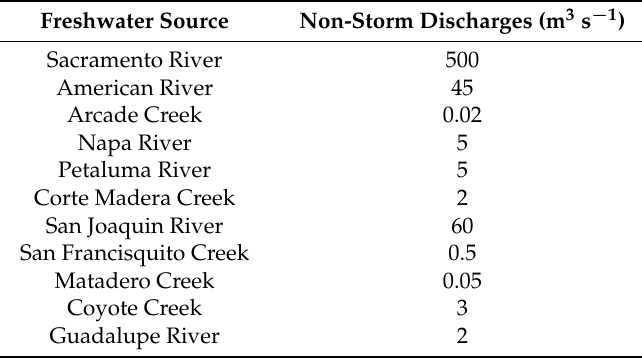
Table 1. Typical winter river discharges applied to river